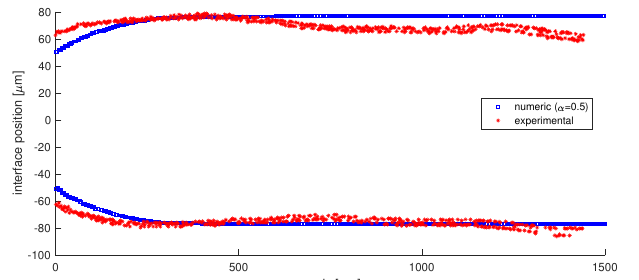
Figure 15. Quantitative validation of the position of the interface. The difference at the junction is generated by the different wetting angle of water and oil at the PDMS surface, in comparison with the contact angle of 90 ◦ imposed in numerical simulations. A slight asymmetry of the interface is experimentally